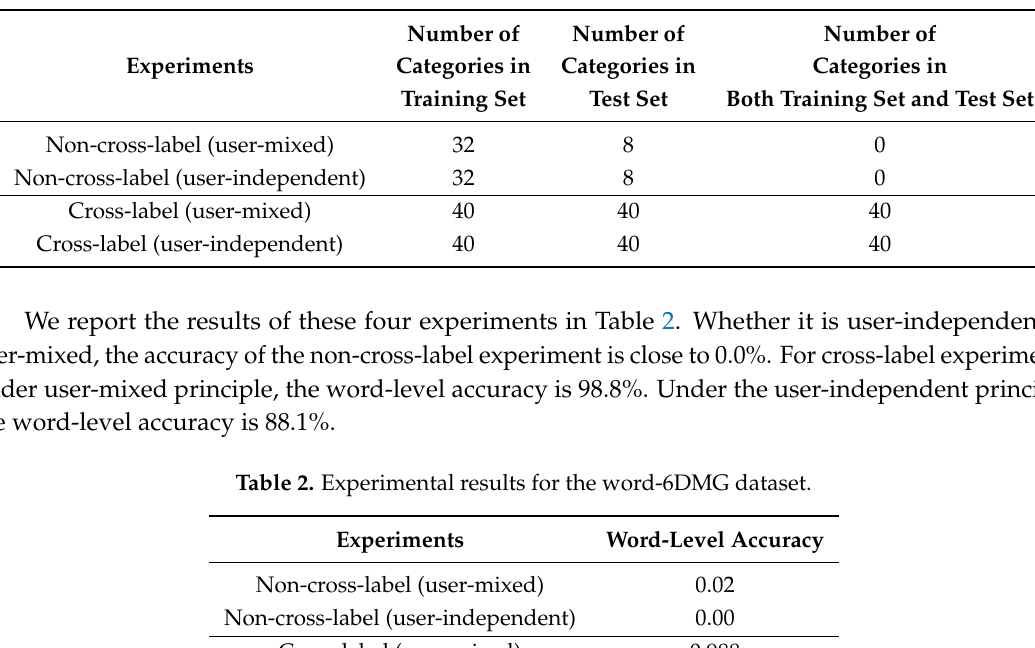
Table 1. Experimental settings for the word-6DMG dataset.